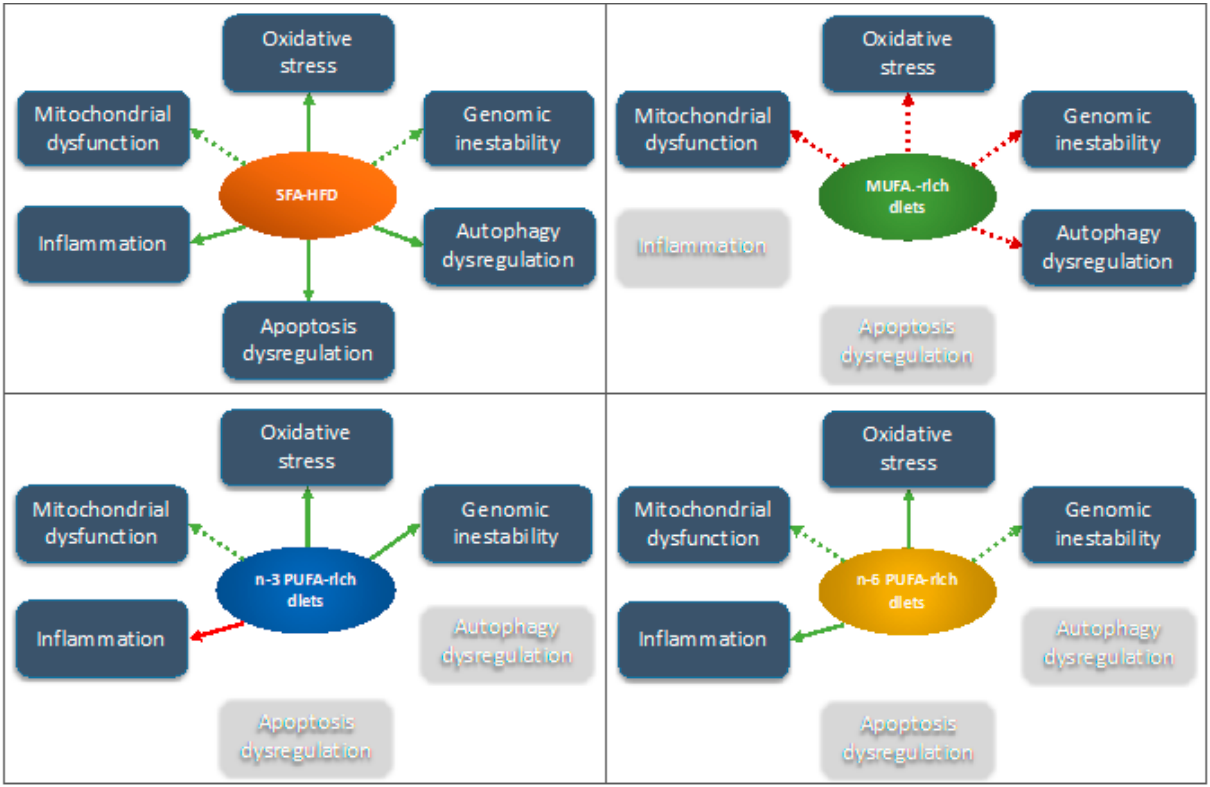
Figure 2. Potential aging-associated mechanisms operating under the observed effects of diets with different dietary fat profile and content on bone biology and metabolism. Green and red colors in the arrows indicate a putative stimulatory or inhibitory effect, respectively. Dashed arrows indicate that to date the effect has been studied only in other tissues different from bone with the exception of systemic inflammation. Abbreviations: HFD: high-fat diet; MUFA: monounsaturated fatty acids, PUFA: polyunsaturated fatty acids, SFA: saturated fatty